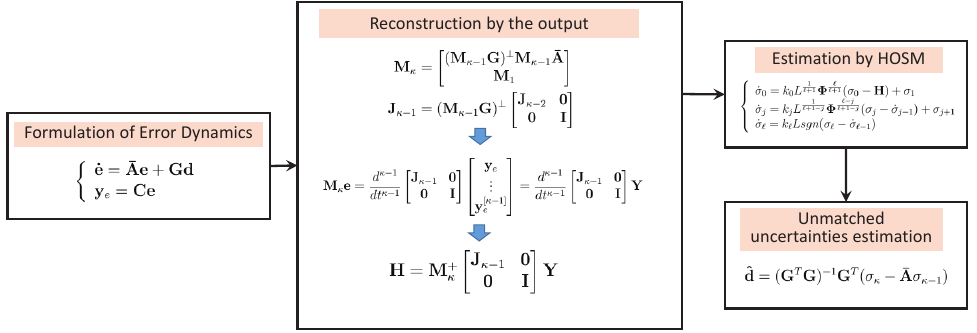
Figure 2. Schematic diagram of the proposed